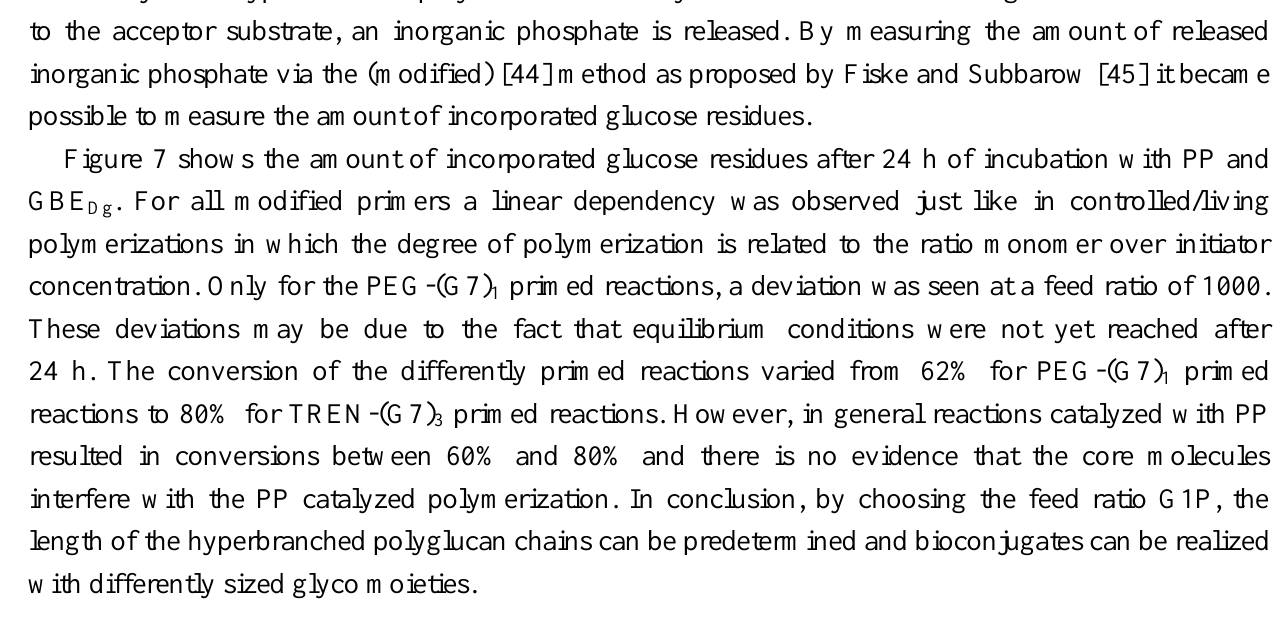
Figure 7. Amount of incorporated glucose residues as a function of the feed ratio